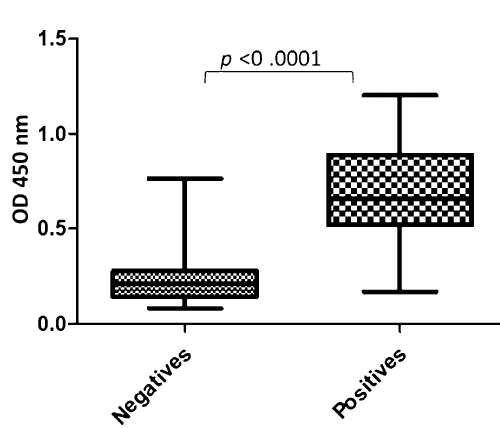
Figure 3. Antibody production in relation to S. mansoni infection status.